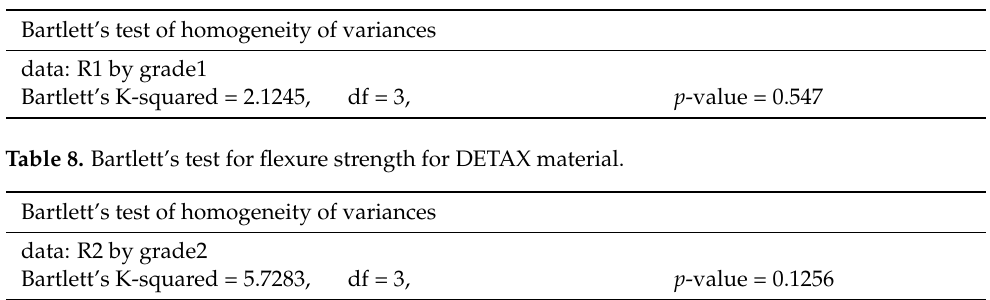
Table 7. Bartlett’s test for flexure strength for NEXTDENT material.